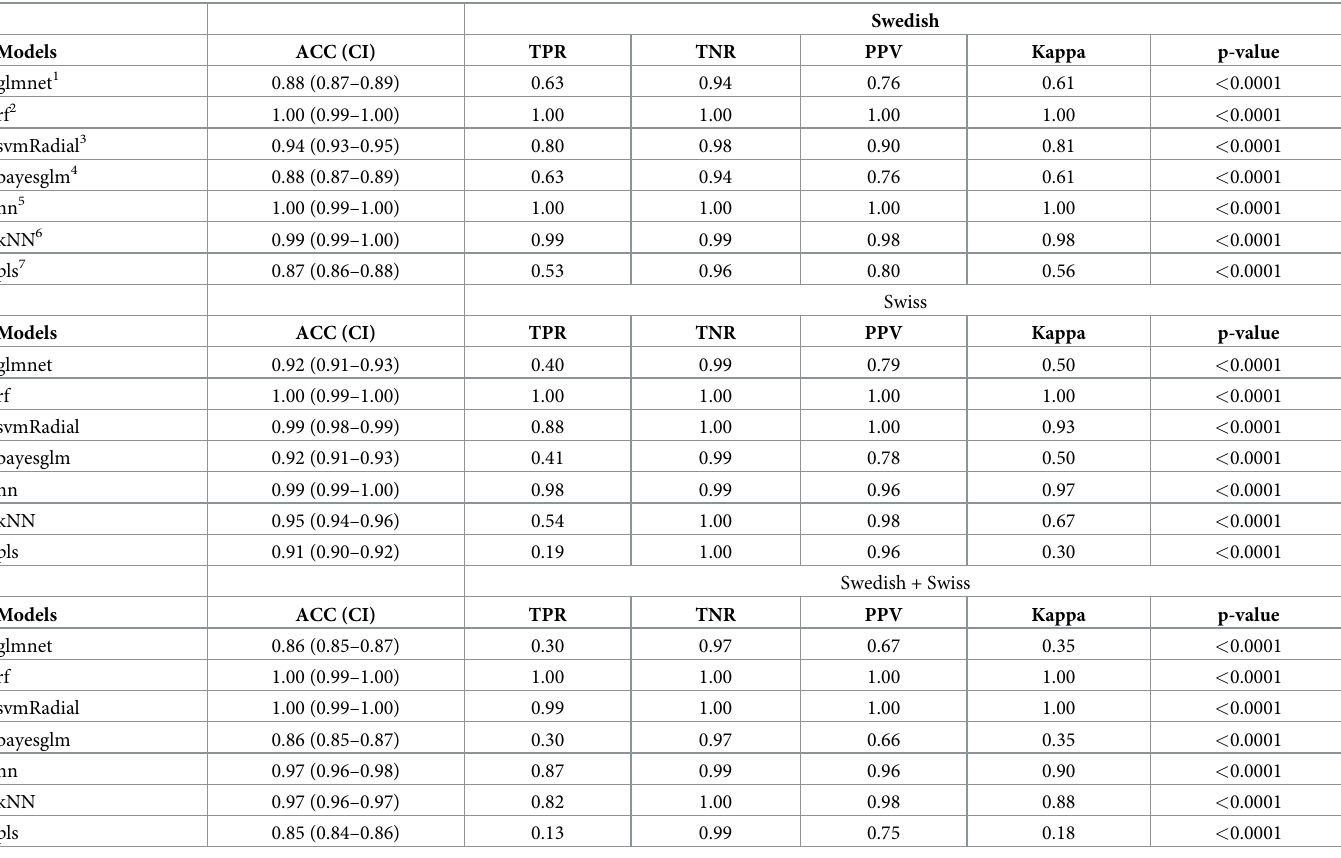
Table 5. Models performances on training data sets for the Swiss, Swedish and Swedish+Swiss data